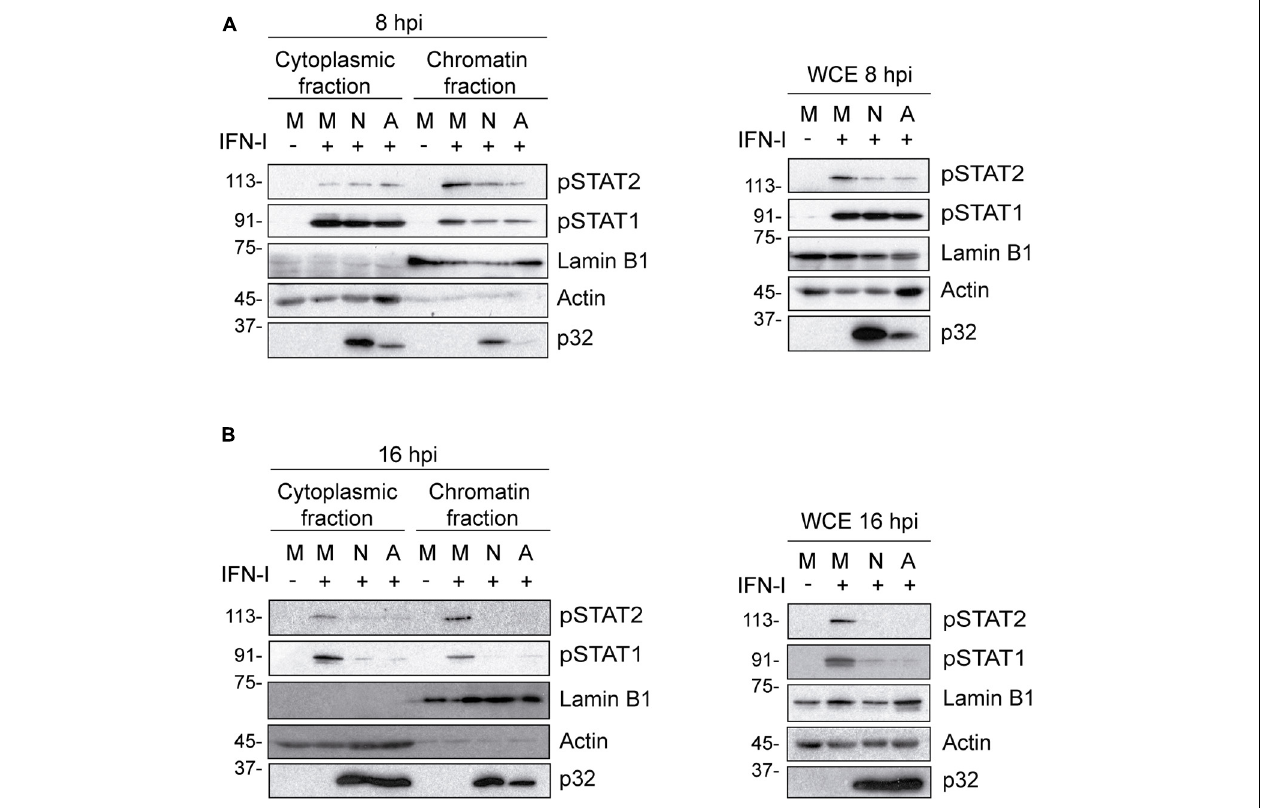
FIGURE 3 | The IFN-I-dependent nuclear localization of pSTAT1 and pSTAT2 is impaired during NH/P68 and Arm/07/CBM/c2 infection. PAMs were mock infected (M) or infected with NH/P68 (N) or Armenia/07/CBM/c2 (A) strain (2 PFU/cell) for 8 (A) or 16 (B) hours. At 7 or 15 hpi, cells were untreated or treated with type I IFN (250 U/ml) during 1 h. Then, cells were collected and nuclear fractionation was performed. The whole cell extract (WCE), cytoplasmic fraction and nuclear chromatin fraction were analyzed by 10% SDS-PAGE, followed by immunoblotting with anti-pSTAT2, anti-pSTAT1 and anti-p32 (viral early protein) antibodies. As controls of the fractionation, nuclear antibody against lamin B1 and cytoplasmic antibody against actin were